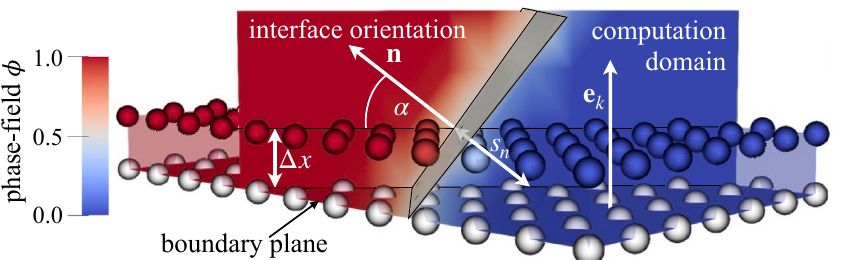
Figure 6. Schematic illustration of the boundary conditions for the phase-field, which enforces the wetting or contact angle α between the interface normal and the direction normal to the boundary